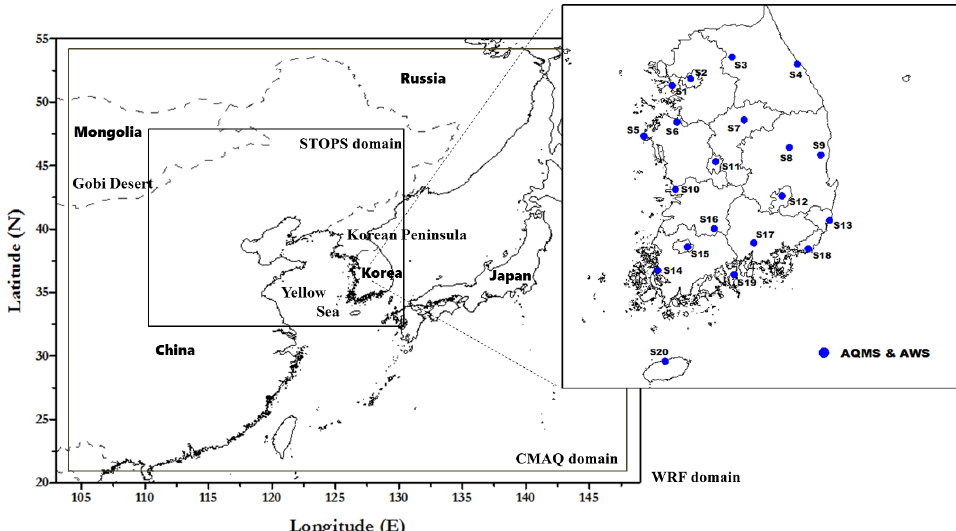
Figure 2. Domains for the WRF, CMAQ, and STOPS modeling. The right panel shows the location of the air quality monitoring stations (AQMS) and automatic weather system (AWS) sites used in this study.